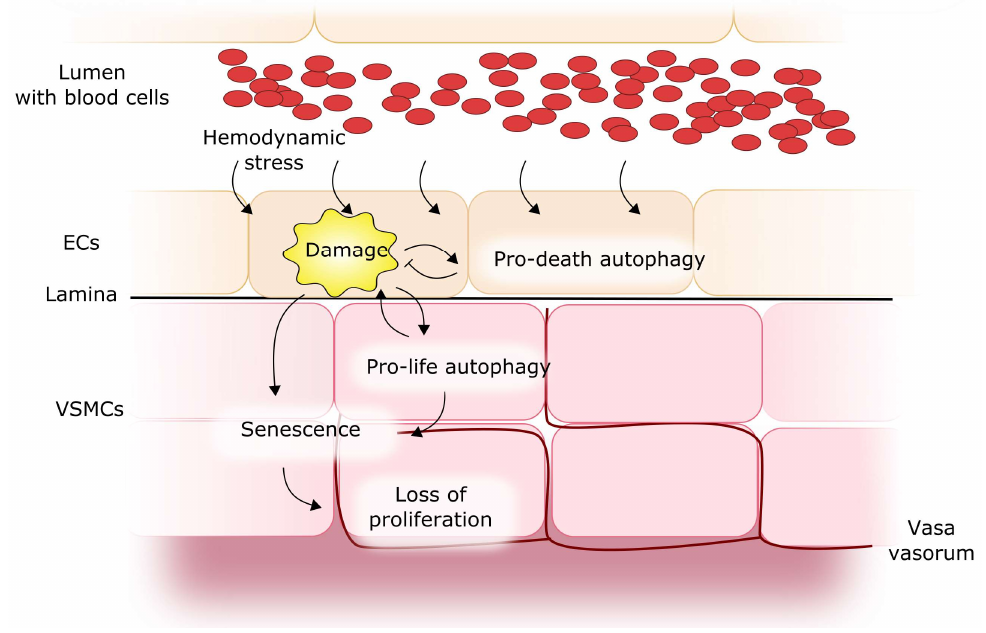
Figure 7. Autophagy in cerebral vessel walls. Damage to endothelial cells (ECs), following a shear stress, can result in pro-death autophagy activation, which increases the consequence of the damage because of a proapoptotic effect and other mechanisms. In addition, disturbances in pro-life autophagy may support the premature senescence of vascular smooth muscle cells (VSMCs), leading to their inability to replace damaged cells.